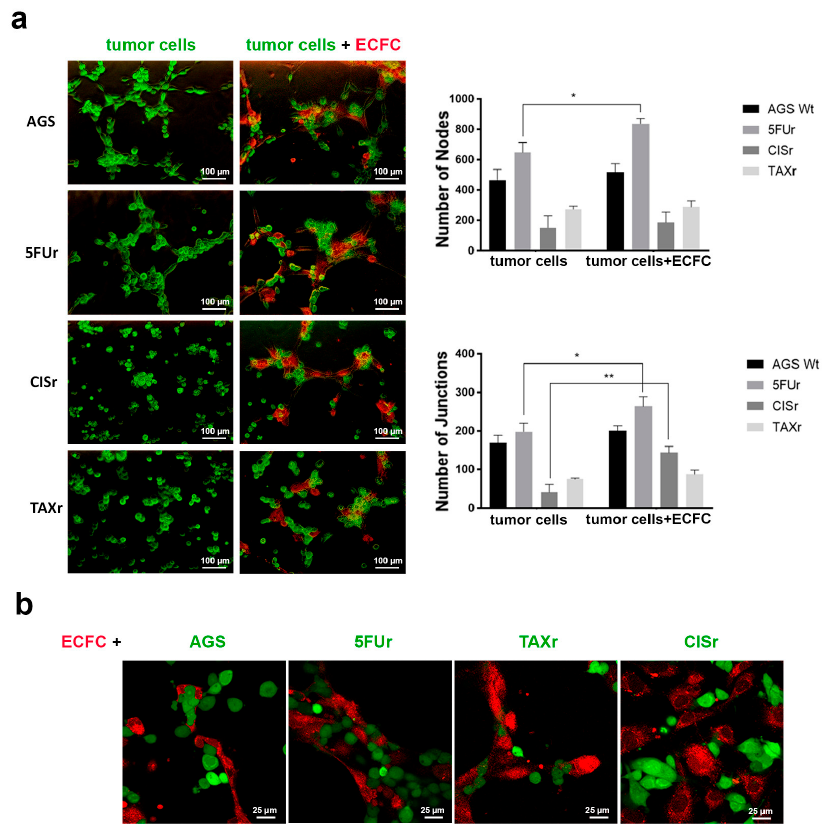
Figure 4. Evaluation of the cooperation with Endothelial Colony Forming Cells. AGS WT and chemoresistant cells were plated with or without ECFCs on Matrigel and pictures were taken at 6 h. The representative images and the number of Nodes and Junctions of tubes are presented. Images were captured at 10X magnification at the fluorescence microscope—scale bar 100 μ m—( a ) and 60X -oil immersion at the confocal microscope—scale bar 25 μ m—( b ). Data are presented as mean ± SD ( n = 3). * p < 0.01; ** p < 0.001 (Two-way ANOVA test).